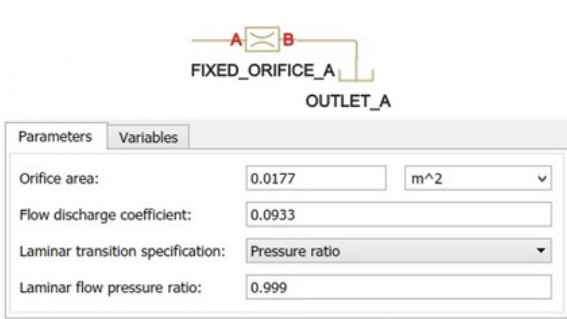
Fig. 3. Fixed orifice setup in MATLAB Simulink [2]